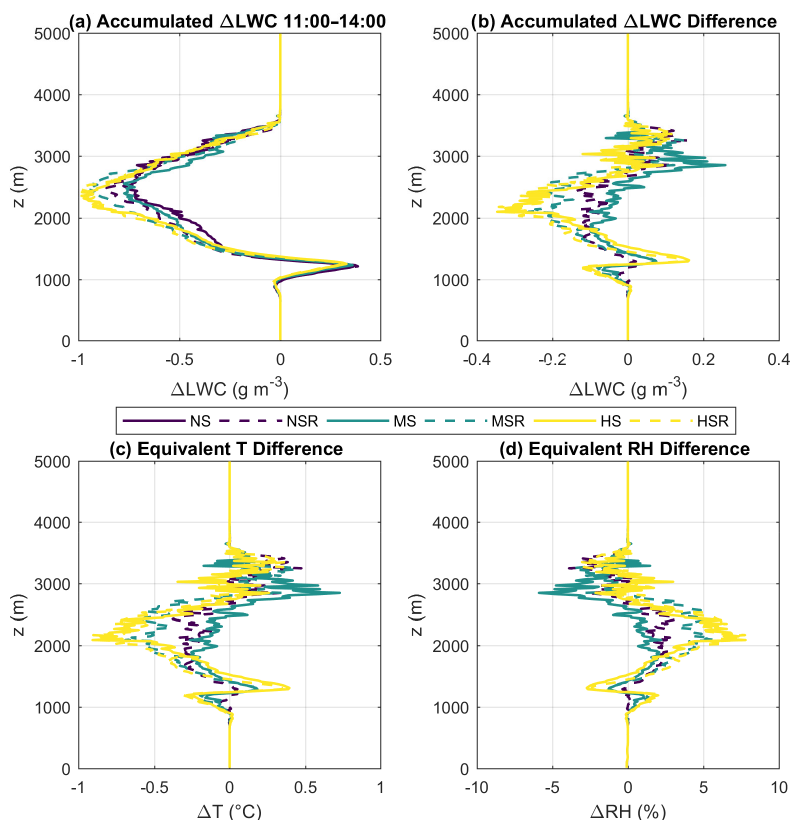
Figure 14. Average effect of the evaporation/condensation rates on the vertical temperature ( T ) and relative humidity (RH) profiles in the vicinity of clouds. Panel (a) shows the time-integrated condensation/evaporation rates between 11:00 and 14:00LT (i.e., the total water vapour converted to cloud liquid water or the reverse). Panel (b) shows the same profiles but as differences between the runs (having NS as reference). Panels (c) and (d) show the estimated T and RH differences as calculated from the curves of panel (b) . This estimate assumes L v = 25 × 10 6 Jkg − 1 (latent heat of condensation) and c p = 1005Jkg − 1 K − 1 (specific heat of air at constant